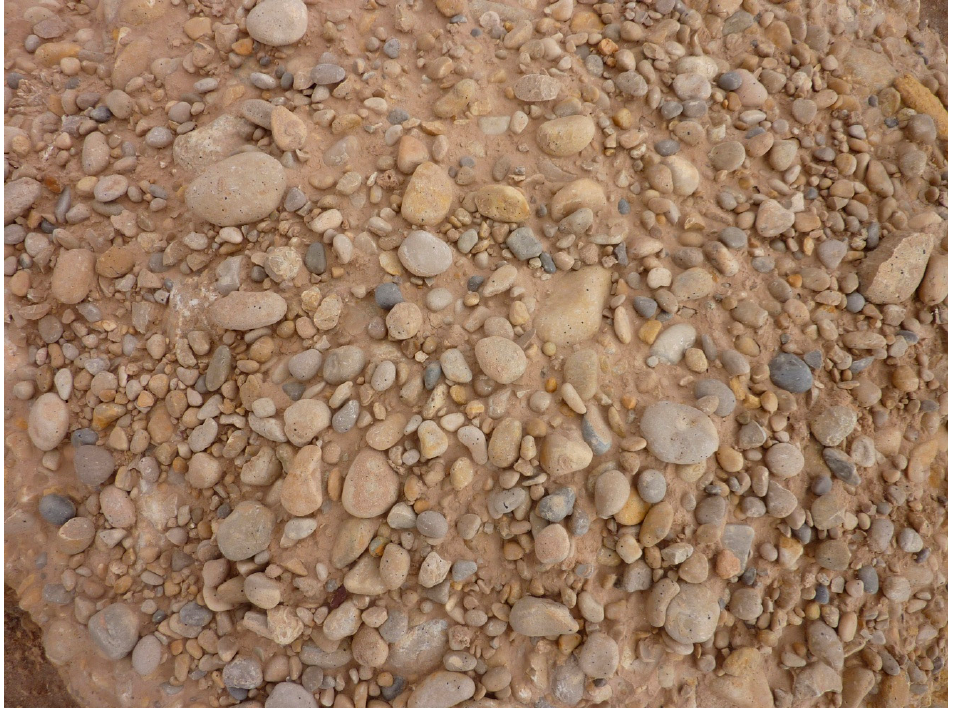
Figure 3. Stony desert pavement as a result of deflation in Southwest Iran, south of Ahwaz (photo: Ch. Opp).